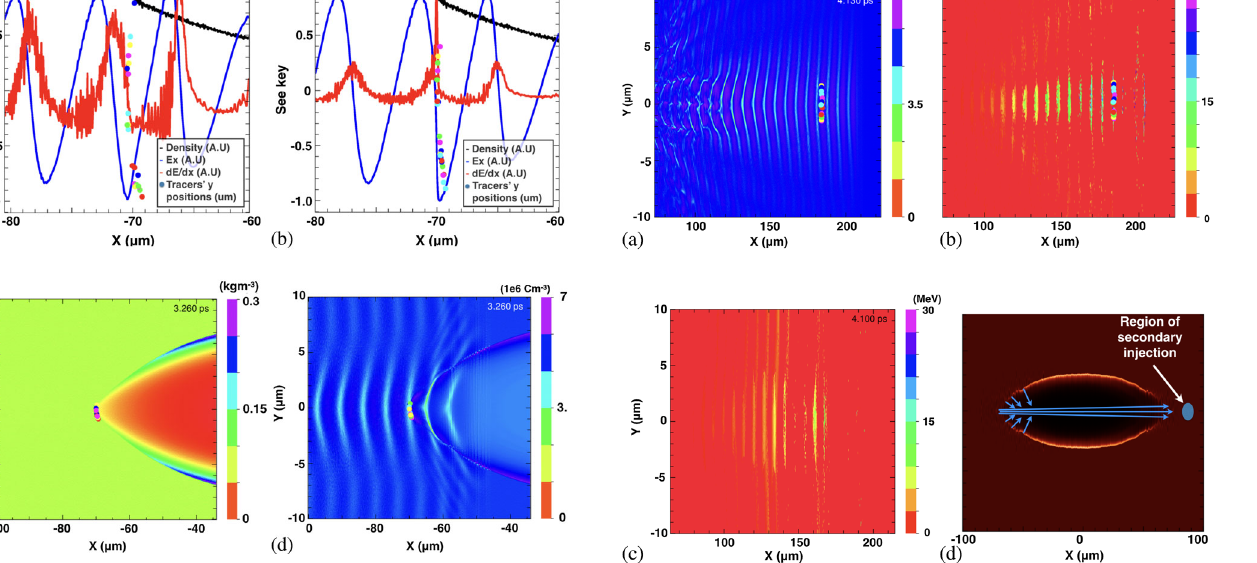
FIG. 5. Plasma parameters after the laser has propagated to X ¼ 205 μ m. The blast-wave ends at X ¼ 70 μ m. (a) The charge density distribution shows the wakefield structures created after the blast-wave; these wakes trap those electrons which are preaccelerated within the blast-wave. (b) This plot of cell- averaged particle kinetic energy shows multiple bunches are accelerated to higher energies by the multiple wakes trailing the laser. The laser is not shown, but is centered at X ¼ 205 μ m. Only those electrons originating from the nitrogen atoms are shown. (c) As per (b) but with a density profile which only varies as a function of x. Here the lateral extent of the bunches is signifi- cantly increased from ∼ 2 μ m to 10 μ m. (d) Blue arrows illustrate the initial propagation directions of those electrons injected at the blast-wave. The electrons are injected approximately perpen- dicularly to the blast-wave at a given location, so only those with small divergence (near y ¼ 0 ) enter the region of secondary